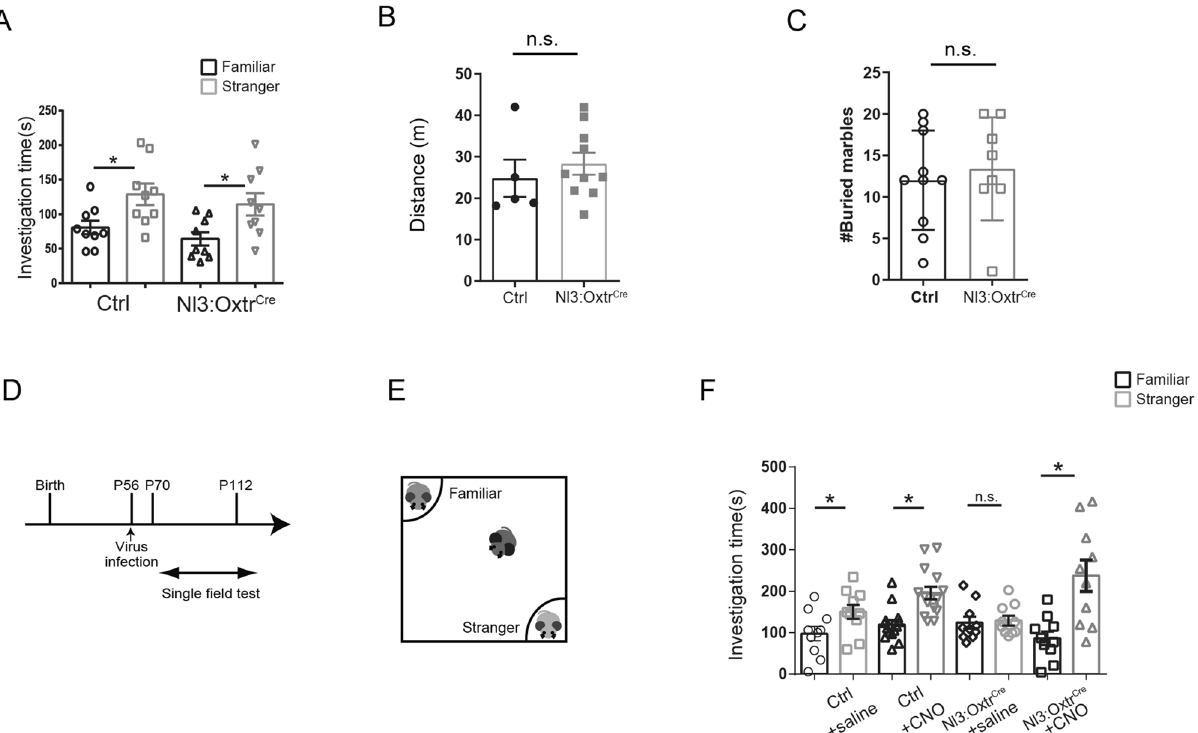
Figure 2. Activation of oxytocin receptor-expressing neurons in the lateral septum ameliorated the abnormal social novelty in Nl3 R451C : Oxtr cre/+ mice. ( A ) Investigation time quantified during the social novelty by three- chamber test (third stage) of Oxtr-Cre (Ctrl) and Nl3 R451C : Oxtr cre/ + mice ( Nl3:Oxtr cre/ + ). N = 9 per group. ( B ) Total distance traveled as measured with open field test. Ctrl: N = 5, Nl3:Oxtr cre/ + : N = 10. ( C ) Number of buried marbles quantified repetitive behavior with the marble burying test. Ctrl: N = 10, Nl3:Oxtr cre/ + : N = 8. ( D ) Schematic diagram of the protocol for virus infection and the single field test in Nl3:Oxtr cre/ + mice. ( E ) Behavioral schematic of the single field test. ( F ) Investigation time during the social novelty (third stage) by single field test, administered saline to Ctrl (N = 10), CNO to Ctrl (N = 15), saline to Nl3:Oxtr cre/ + (N = 10) and CNO to Nl3:Oxtr cre/ + (N = 10). All mice using the single field test were infected with hM3Dq vector earlier than 2 weeks. Paired t -tests were performed for three-chamber test and single field test ( A , F ) and Mann–Whitney tests were performed for open field test and marble burying test ( B , C ). * , ** p < 0.05,